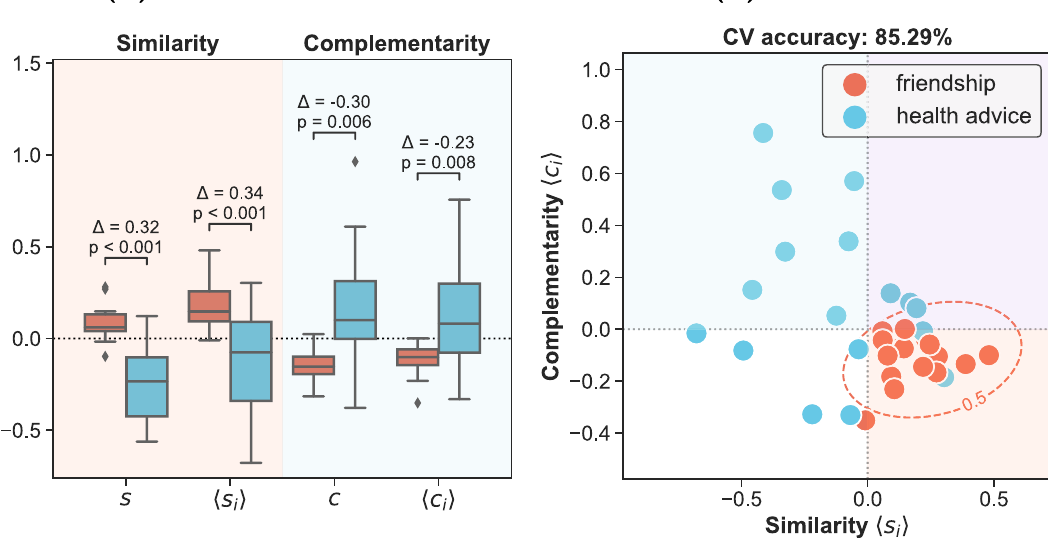
Figure 7. Comparison of structural coefficients between friendship and health advice networks in 17 Ugandan villages. Observed values were calibrated based on 500 samples from UBCM (see “Materials and methods” section). ( A ) Univariate distributions of global and average nodewise coefficients reveal significant differences between the friendship and health advice networks which are consistent with the hypothesis. The friendship networks feature significantly higher structural similarity and the health advice networks higher complementarity. The average differences between networks from the same villages are denoted by (cid:31) ’s. Statistical significance was assessed using one-sample t -test with two-sided null hypothesis applied to the differences; p values were adjusted for multiple testing using Holm–Bonferroni method. ( B ) Bivariate distribution of the calibrated values of the average nodewise similarity and complementarity coefficients. The decision boundary separating the friendship and health advice networks (marked in red) is based on Quadratic Discriminant Analysis (QDA). The out-of-sample classification accuracy was estimated with stratified 17-fold cross-validation (one fold per